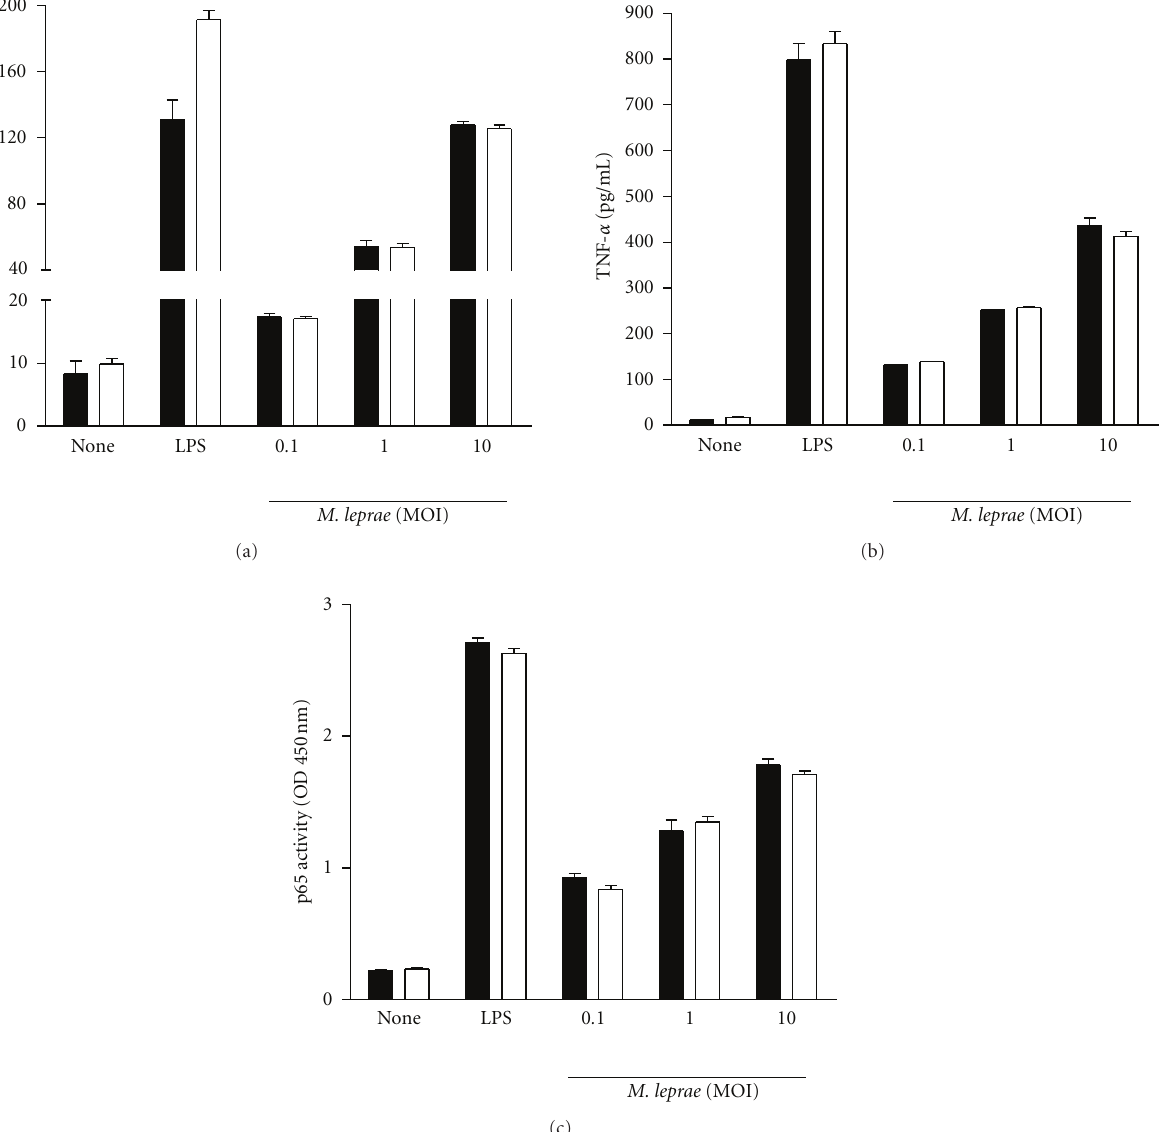
Figure 1: TNF- α and IL-12 production and NF- κ B activation in response to M. leprae infection in macrophages from A/J and C57BL/6 mice. Macrophages (10 6 ) from C57BL/6 and A/J mice were treated with LPS (100ng/ml) and M. leprae (MOI of 0.1, 1.0, and 10.0) for 18 h, and supernatants and cell extracts were assayed for cytokines (IL-12 and TNF- α ) and NF- κ B, respectively. Open bar and closed bar represent macrophages from C57BL/6 and A/J mice, respectively. Data are representative of at least three independent experiments, each performed in